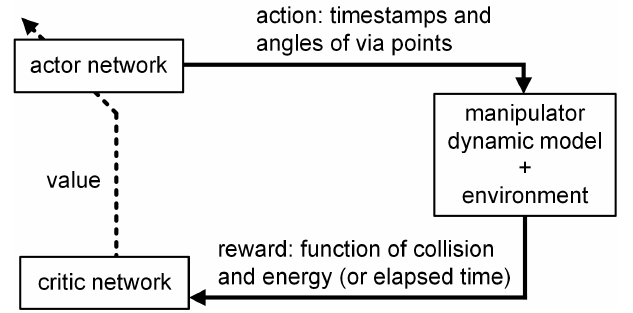
Figure 5. The actor-critic structure in the proximal policy optimization